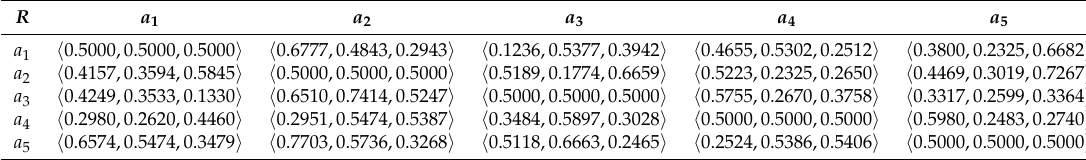
Table 12. The collective SVNPR of all the above individual SVNPRs.